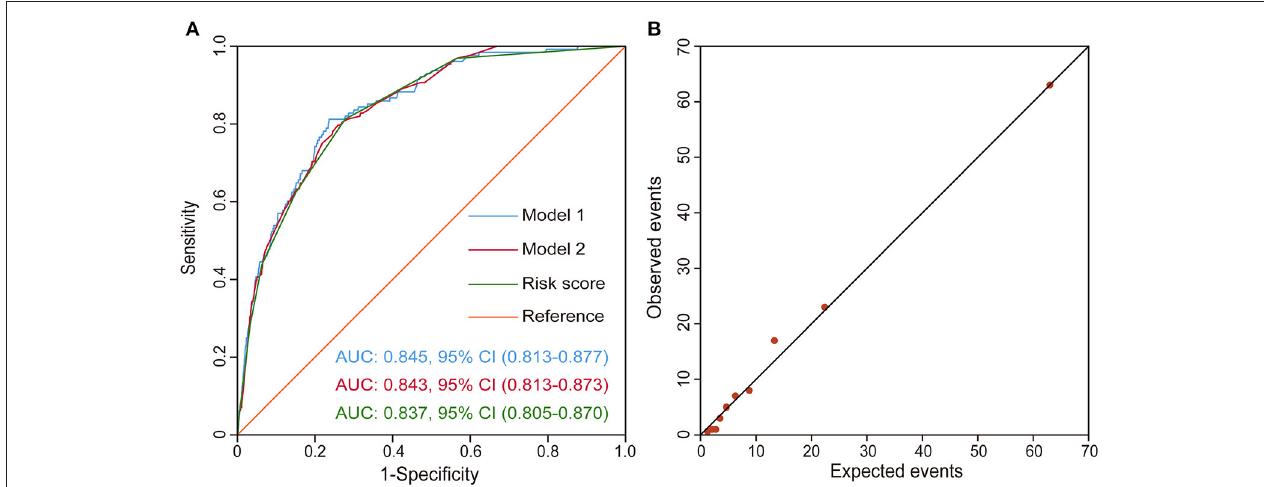
FIGURE 3 | Validation of the risk score model. (A) ROC curves drawn using the risk score model, Model 1, and Model 2 in the derivation set. Model 1 is the first model with continuous variables and Model 2 is the second model with a dichotomy of the continuous variables. (B) Observed vs. expected events by predicted risk category. The correlation between observed and predicted events is 0.99. CI, confidence interval; ROC curve, receiver operating characteristic curve.